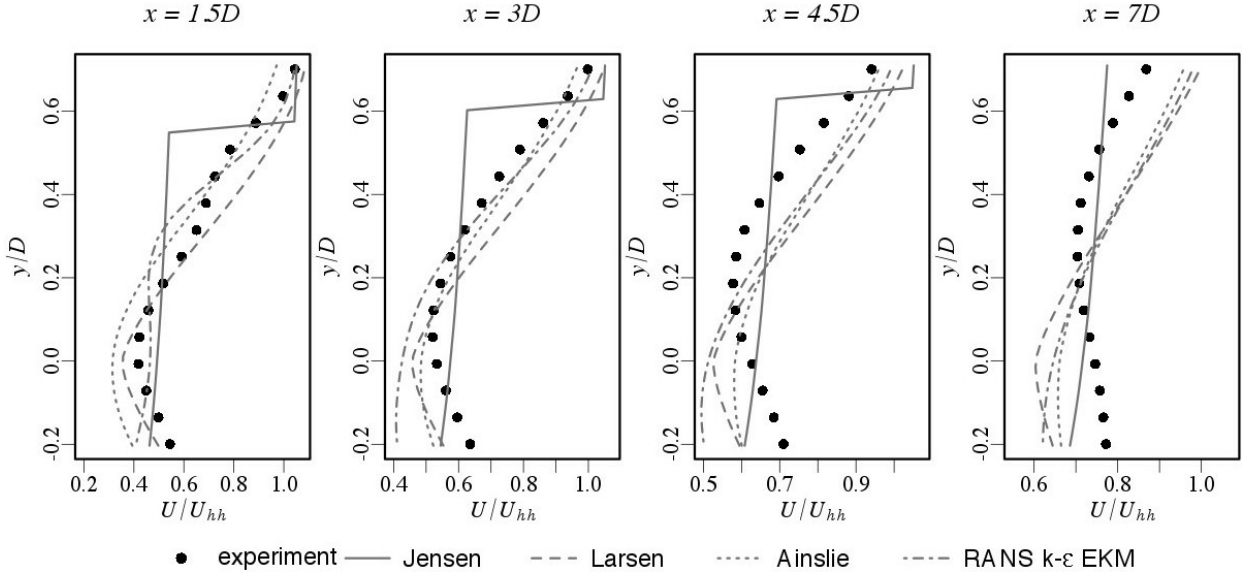
Figure 20. Comparison of measured mean profiles of U/U the floating